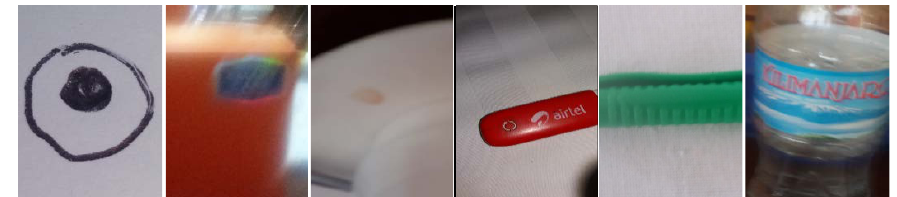
Figure 1. Non-cervix image samples in one collected dataset.